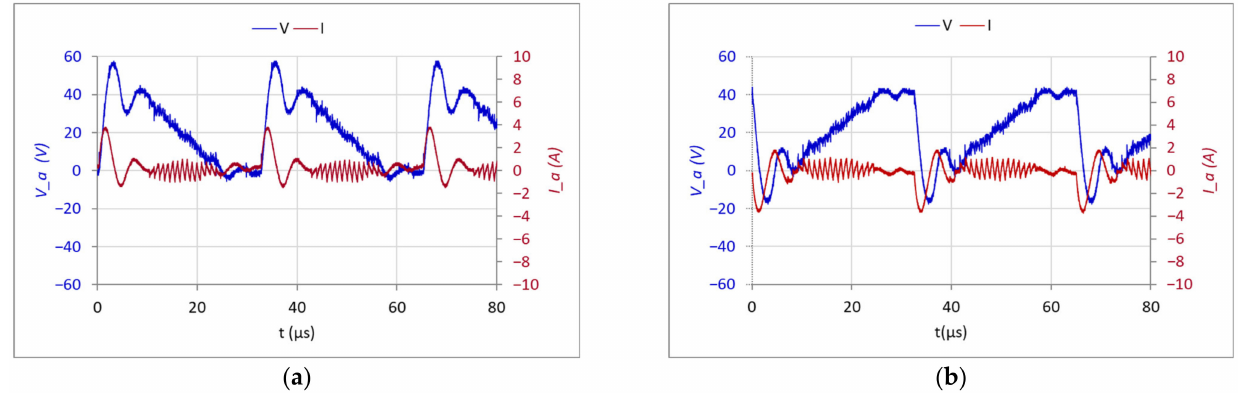
Figure 4. ( a ) Voltage and current waveforms during fast charging and slow discharging of the piezoelectric multilayer actuator. ( b ) Voltage and current waveform during fast discharging and slow charging of the piezoelectric multilayer